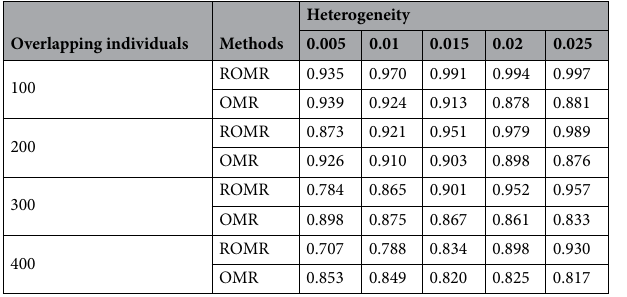
Table 6. The powers under different heterogeneity with different overlapping data for the test of SNP and SNP-environment joint effects.